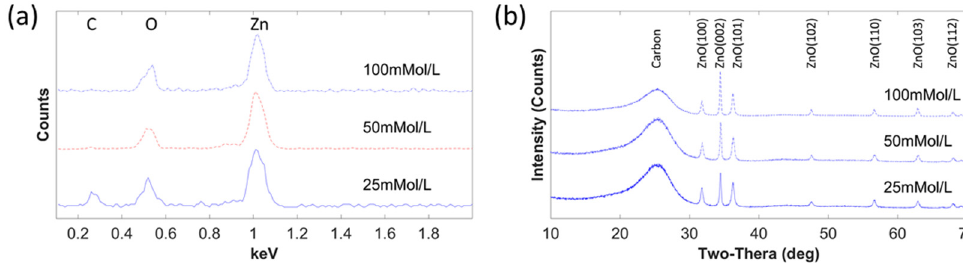
Figure 3. ( a ) EDX spectrum of ZnO nanowires on single carbon fiber; ( b ) XRD diffraction of ZnO nanowires with different morphologies.